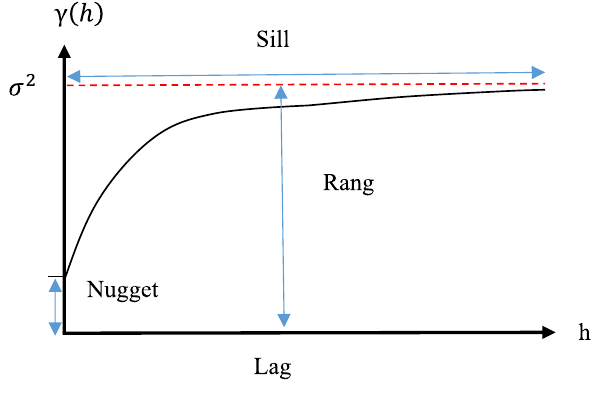
Fig. 3 Key parameters of